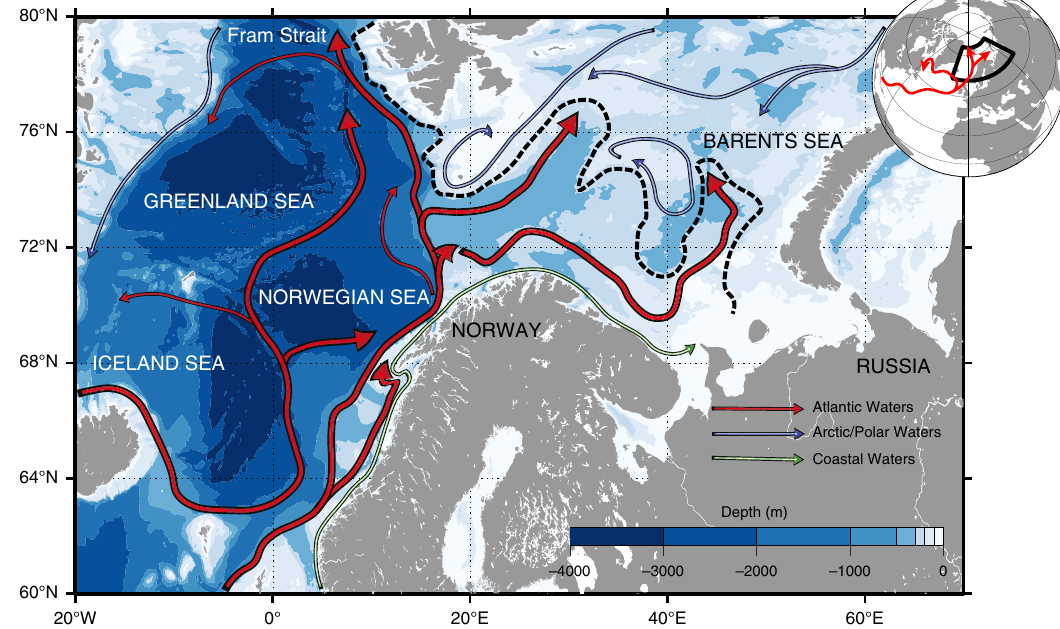
Fig. 1 The European Arctic Corridor (EAC). Bathymetry and surface circulation. The Atlantic currents are in red, the Arctic or Polar Waters are in blue and the Coastal Waters are in green. The southern Barents Sea Polar Front 4 is illustrated in black dashed line and separates the Atlantic Waters from the colder and fresher waters from the